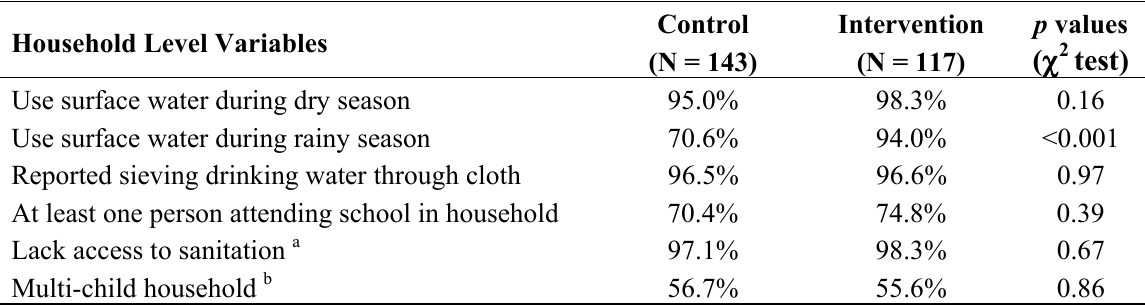
Table 2 . Selected characteristics regarding demographics, water and sanitation for control (no BSF) and intervention (BSF) households in a randomized controlled trial of the